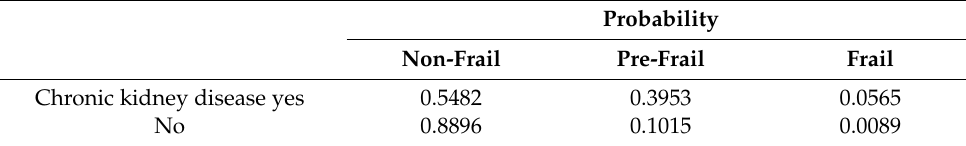
Table 5. Predicted probabilities derived from the ordinal regression model.